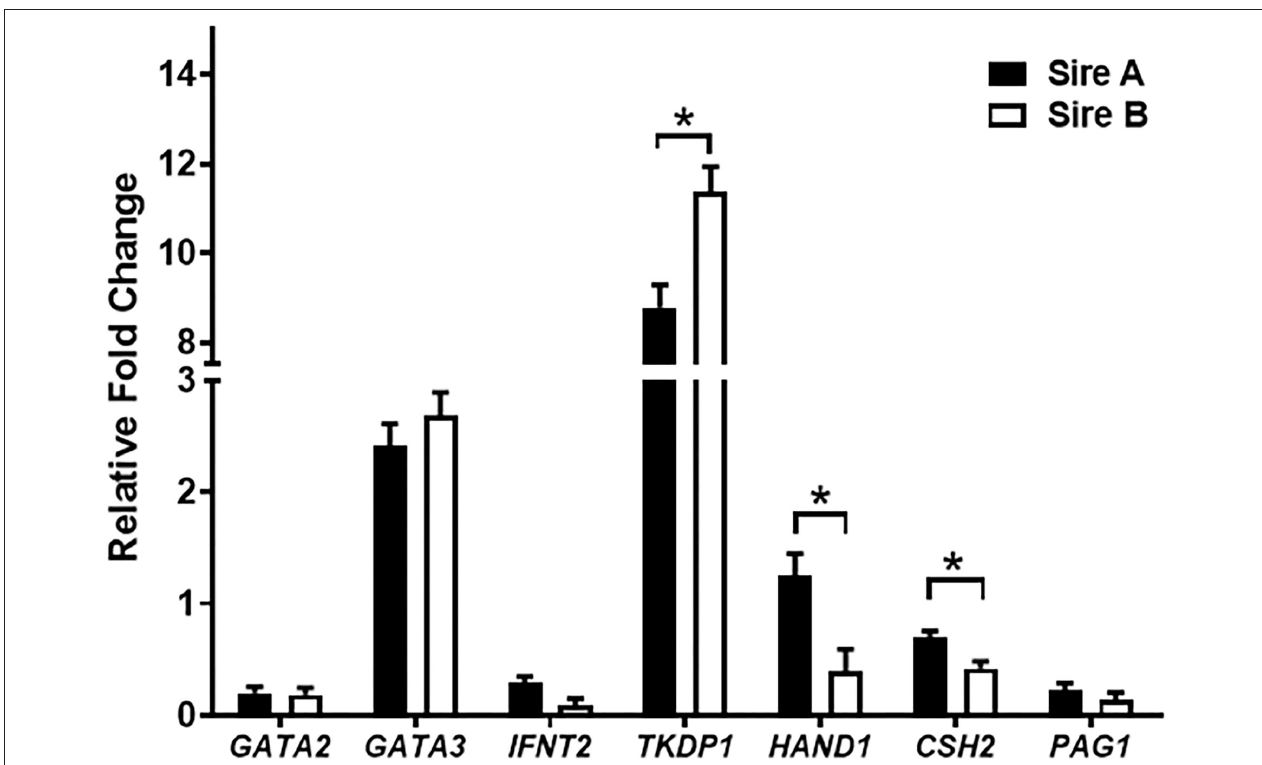
FIGURE 3 | Gene expression in trophectoderm cell outgrowths on day 30. A total of 20 cell outgrowths were analyzed (10 outgrowths/sire). Values are presented as LSMEANS ± SEM. The * denotes difference ( P < 0.05 ) between